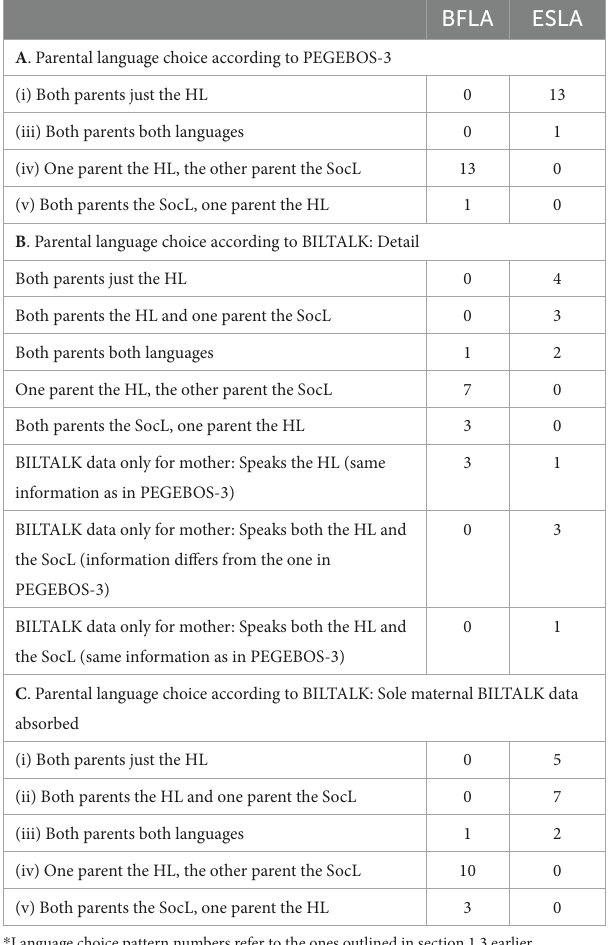
* Language choice pattern numbers refer to the ones outlined in section 1.3